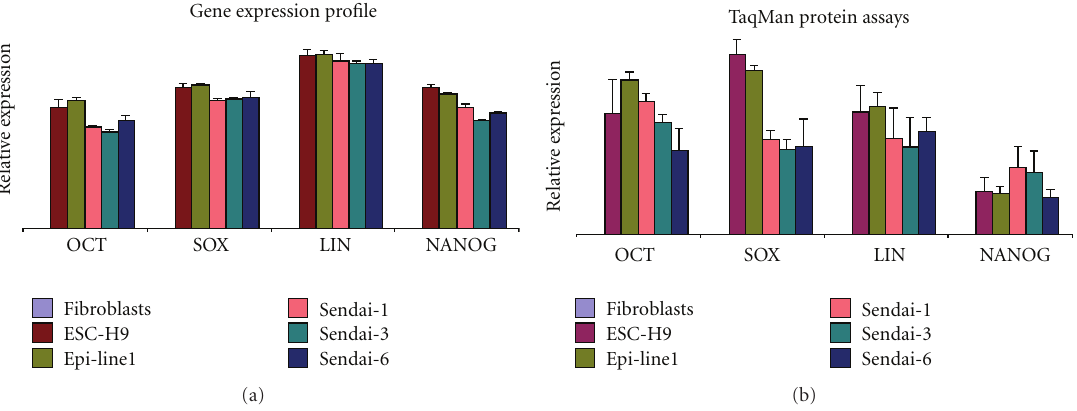
Figure 4: (a) TaqMan Gene Expression Assays of OCT4/POU5F1, SOX2, LIN28, and NANOG were compared among the WA09 hESC line, an episomally derived iPSC line (Epi-line 1), and three Sendai-derived iPSC lines (Sendai 1, 3, and 6). Samples were normalized against the endogenous reference B-actin. (b) TaqMan Protein Assays of OCT4/POU5F1, SOX2, LIN28, and NANOG are compared among the WA09 hESC line, an episomally derived iPSC line (Epi-line 1), and three Sendai-derived iPSC lines (Sendai 1, 3, and 6). Samples were normalized against the endogenous reference 18S ribosomal genomic DNA and plotted relative fold change to the expression level of untransduced human dermal fibroblasts.